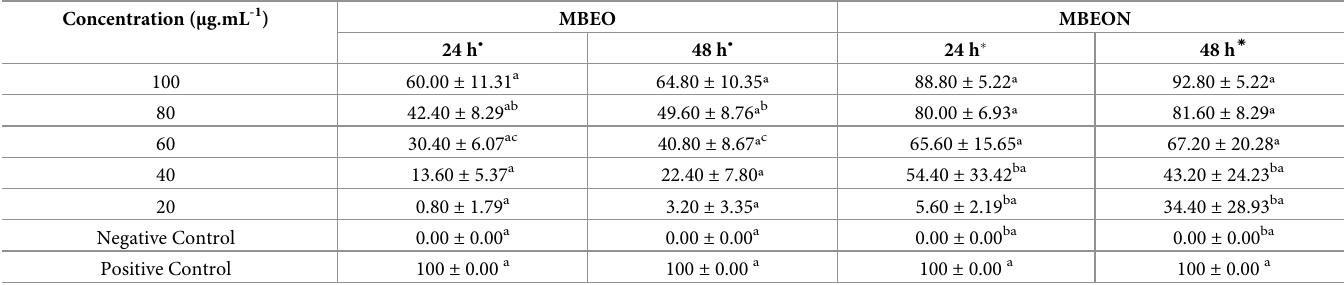
Table 4. Mortality of A . aegypti larvae in different concentrations of essential oil and nano-emulsion of A . triplinervis morphotype B. Concentration ( μ g.mL -1 )